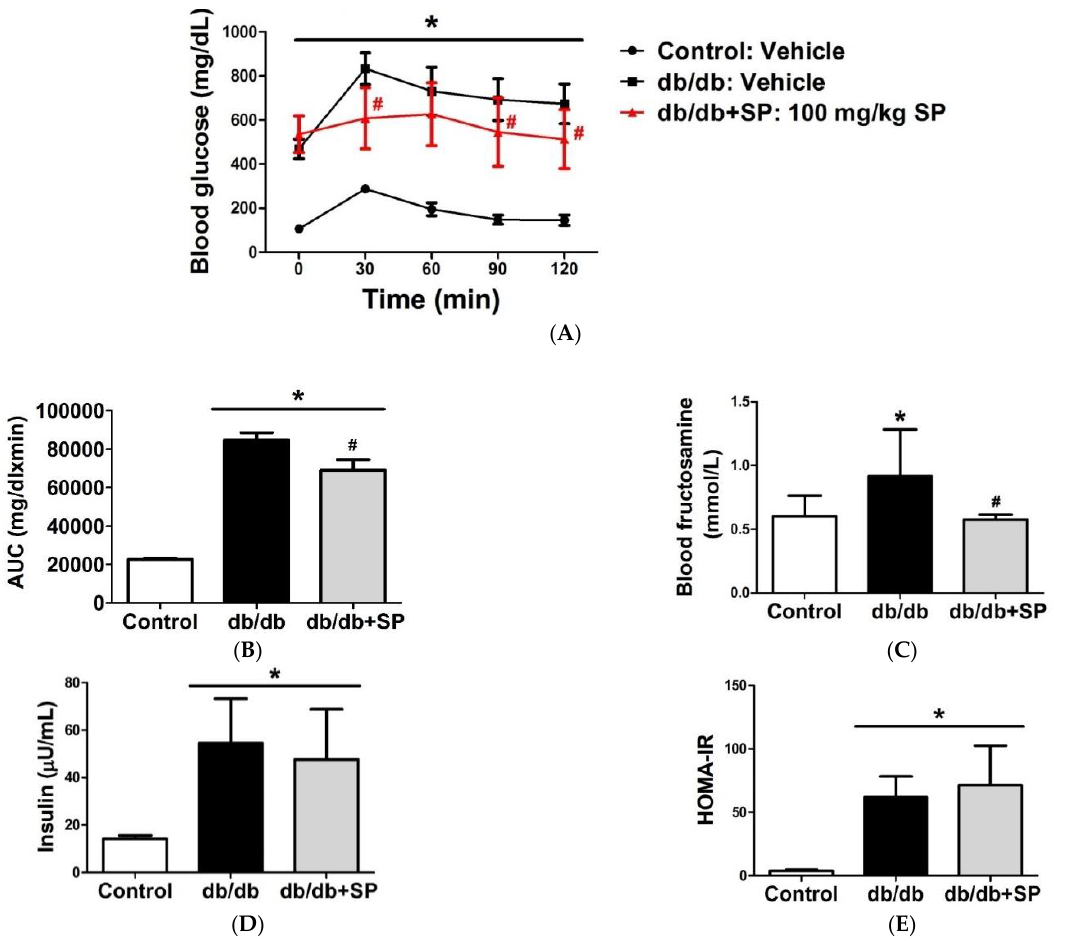
Figure 8. Treatment of scoparone on db/db mice for two weeks improves glucose tolerance and insulin sensitivity. Treatment of scoparone on db/db mice for two weeks improves glucose tolerance. ( A ) db/db mice were treated with scoparone or vehicle (P.O.) for 2 weeks. After 12 h of fasting, glucose tolerance tests were performed and blood glucose levels were assessed ( n = 6) ( B ) Area under curve of blood glucose level were calculated. Fructosamine ( C ) and insulin ( D ) levels were measured. ( E ) Homeostasis Model Assessment (HOMA) was calculated as HOMA-IR index = insulin(μU/mL) × glucose(mmol/L)/22.5. (* statistically significant compared with Control group; # statistically significant compared with db/db group; Probability of < 0.05 was considered to be significant)